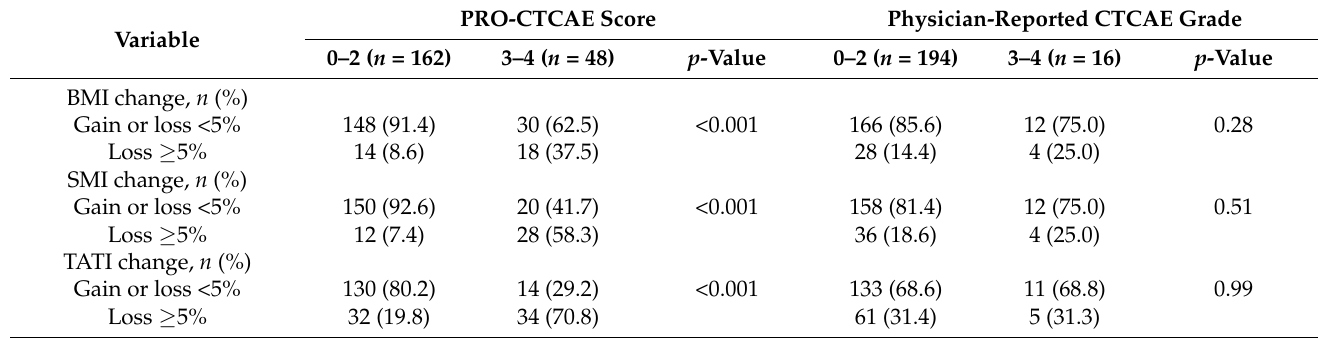
Table 2. Body composition change groups after treatment by PRO-CTCAE or physician-reported CTCAE.